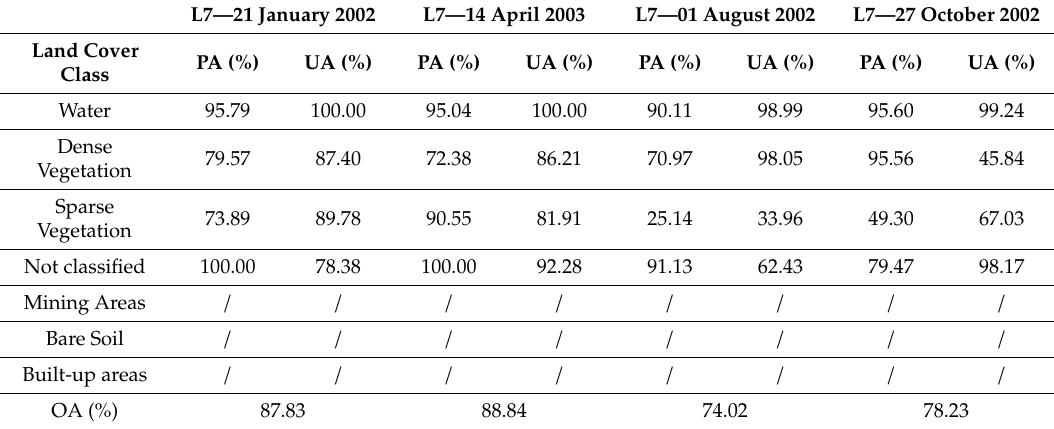
Table 4. OA, PA, and UA obtained through the application of Optimized Soil Adjusted Vegetation Index (OSAVI) on the data acquired by Landsat 7 mission. UA, user’s accuracy; PA, producer’s accuracy; OA, overall accuracy.